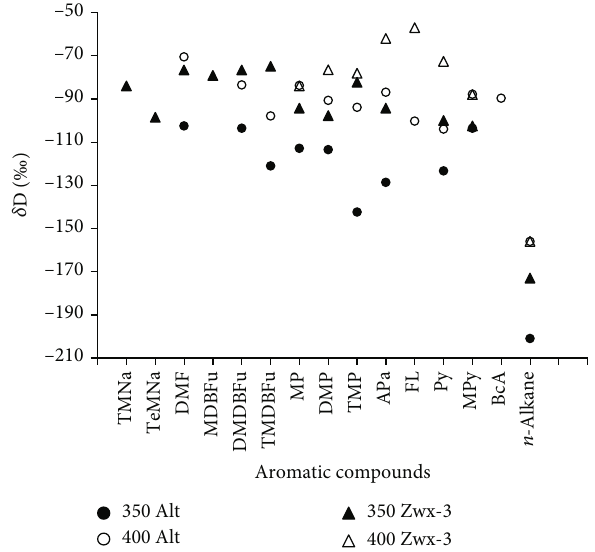
Figure 3: δ D values of aromatic compounds in the pyrolysis samples